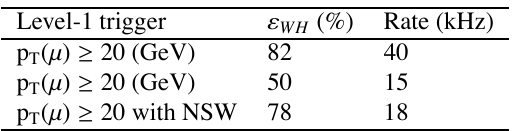
Table 3. The Level-1 trigger e ffi ciency for the W + H process ( ε WH ) and the corresponding estimated trigger rates demonstrating the e ff ectiveness of the new small wheel (NSW) chambers in maintaining the high e ffi ciency and providing high background rejection.